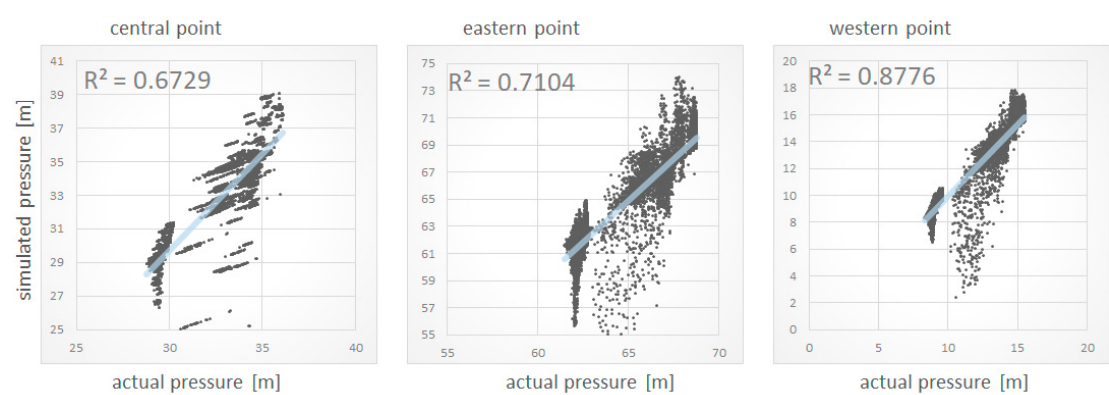
Figure 14. Scatterplots of actual and simulated hourly pressure values in m for three cello points: the central at the left and the eastern at the middle, and the western at the right. Table 3. Simulated and actual trimester-average pressure values in m for the three cello points. Cello Location Trimester Simulated Actual % Error Central point